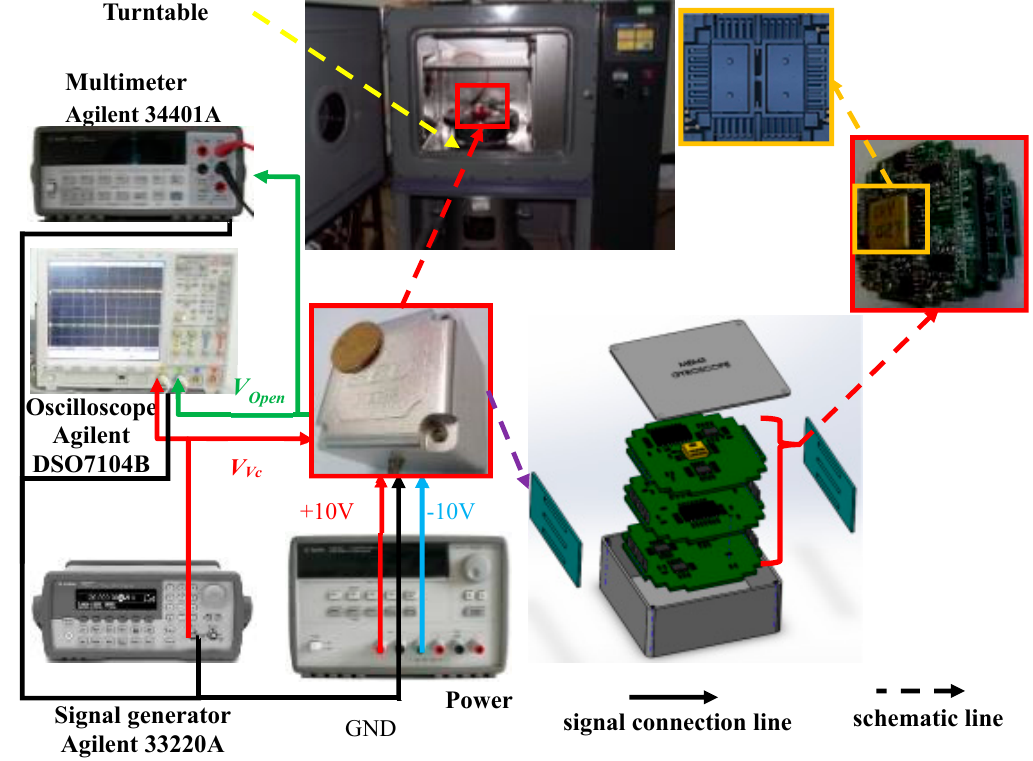
Figure 5. Circuit of dual-mass line vibrating gyroscope.